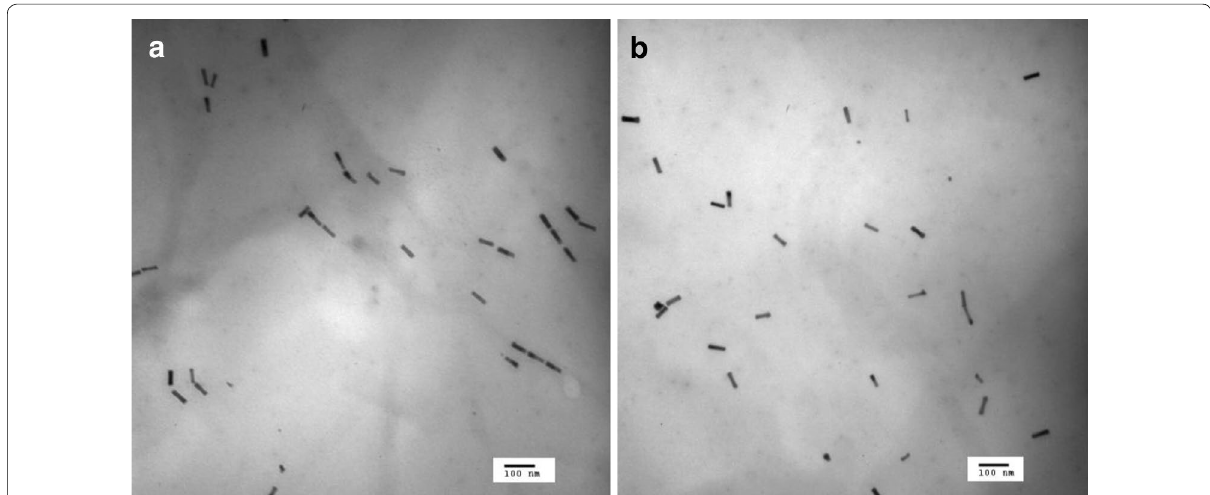
Fig. 9 TEM images (scale bars